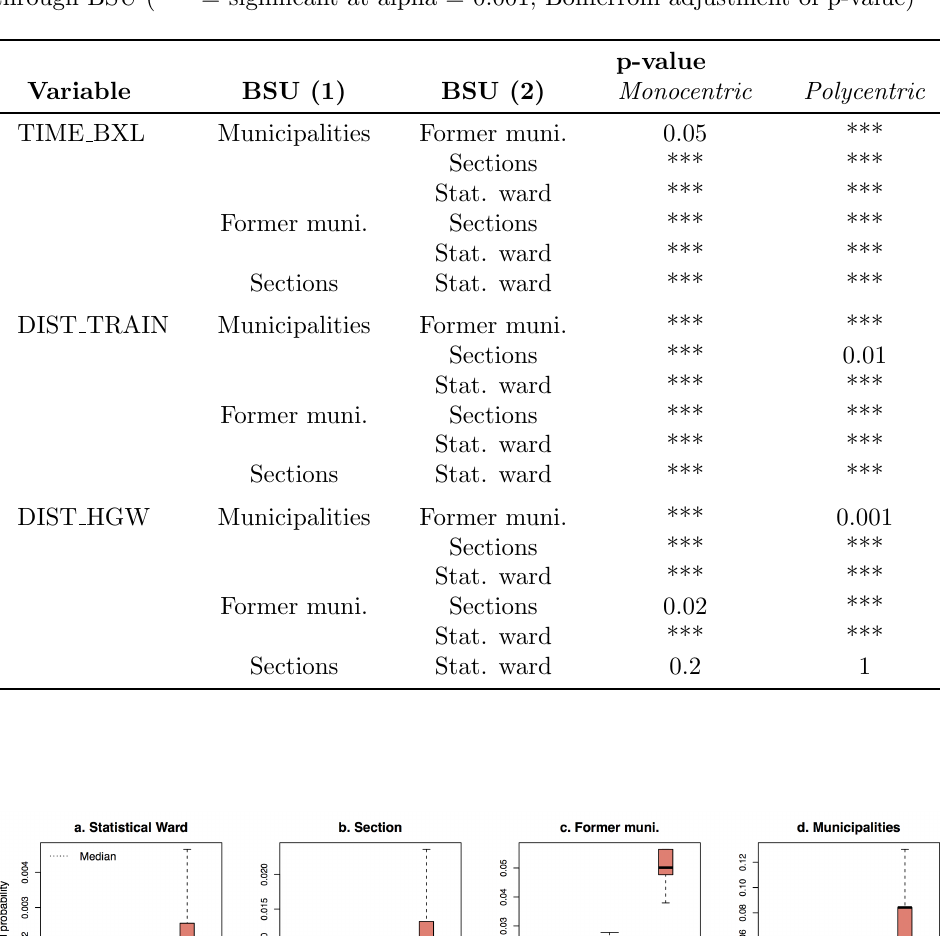
REGION : Volume 2, Number 1,